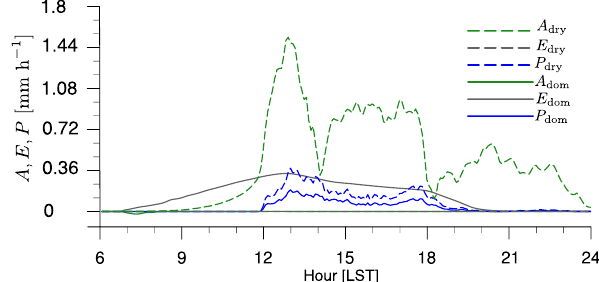
Figure 5. Different terms of the moisture balance (Eq. A3) com- puted for the entire domain (subscript dom , solid lines) and for the dry patch (subscript dry , dashed lines) in the DA_20_100 case. A indicates advection, E evaporation and P precipitation. Units are millimeters per hour. Note that all variables in this figure are instan-